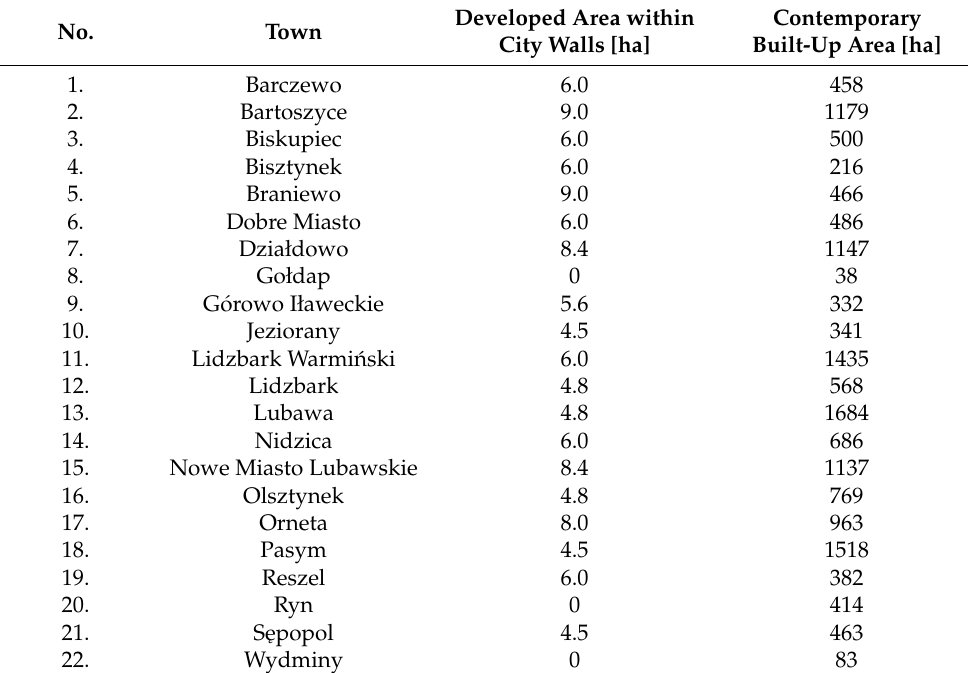
Table 12. Towns in Warmia and Mazury—developed